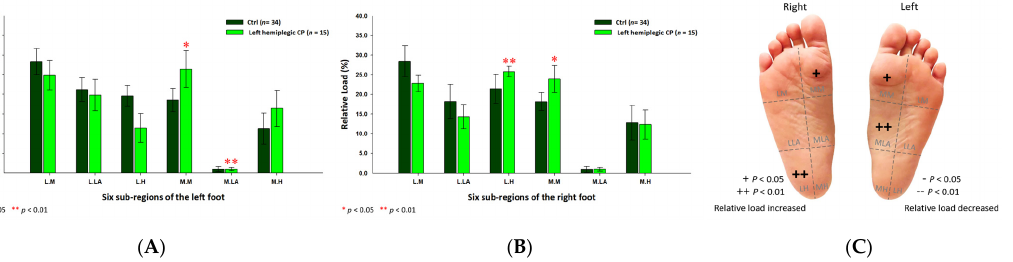
Figure 7. The percentage of six subregional relative loads of ( A ) left and ( B ) right feet in female students during static stance. The changes in pressure distribution are illustrated in ( C ) foot plantar diagram. Significant differences between the female control group and the female left hemiplegic CP group were determined as * p < 0.05 and ** p < 0.01. 3.6. Plantar Pressure Distribution of the Six Subregions in the Right Hemiplegic CP Students Based on the results of right hemiplegic CP students, the relative loads were discov- ered to be higher at the medial metatarsal (27.08% ± 3.03%; p < 0.01) of the right foot, while lower at the lateral metatarsal (22.12% ± 2.00%; p < 0.05) of the left foot (Figure 8) as com- pared with the control group.